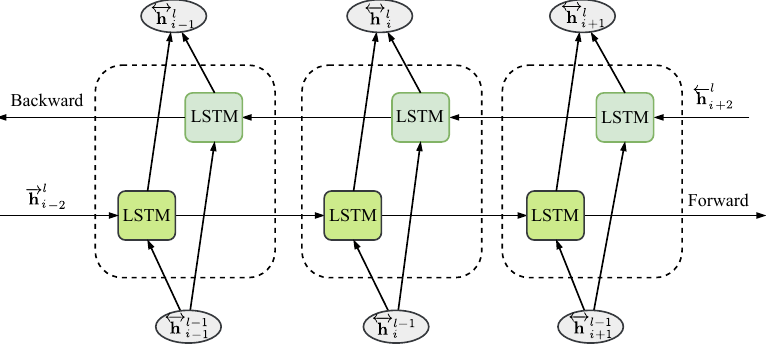
Figure 2. BDLSTM layer with both forward and backward LSTM layers. LSAP, linear sum assignment